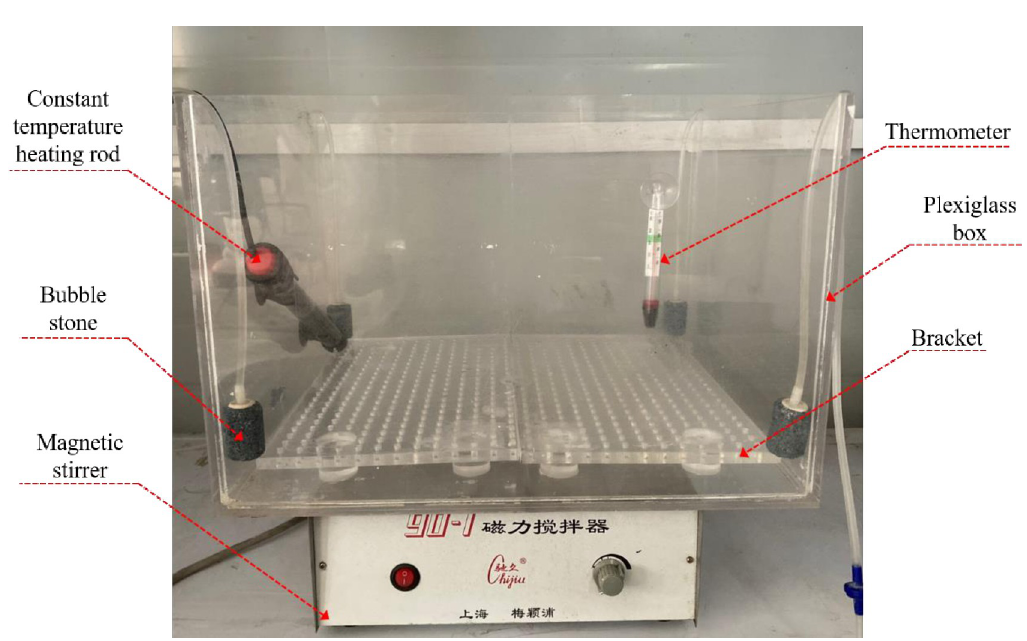
Fig 3. Device for immersion